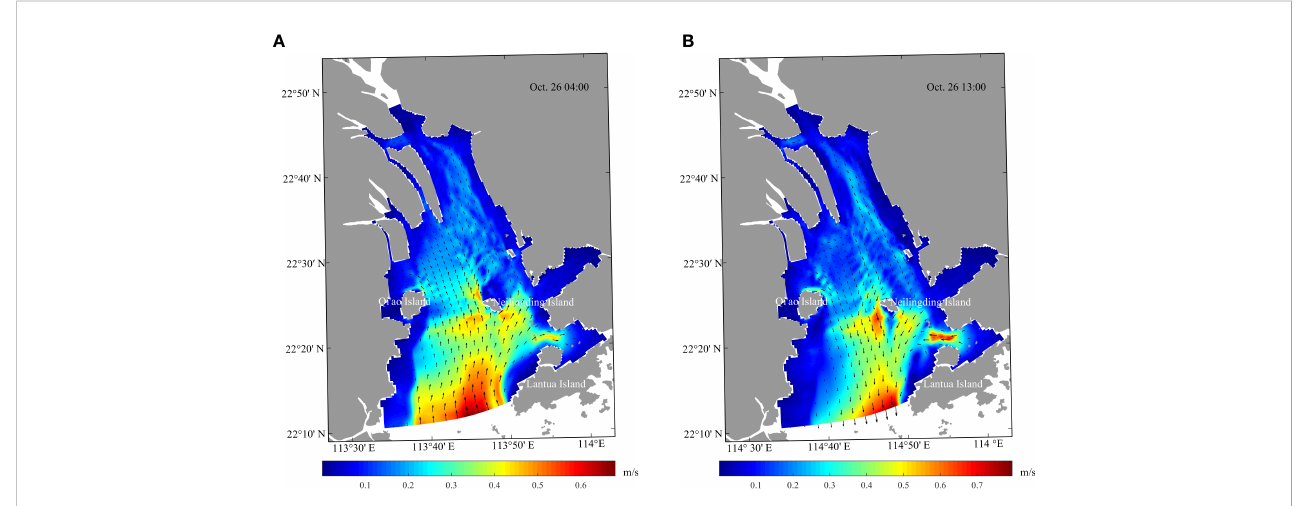
FIGURE 9 Simulated fl ow fi elds during (A) fl ood tide; and (B) ebb